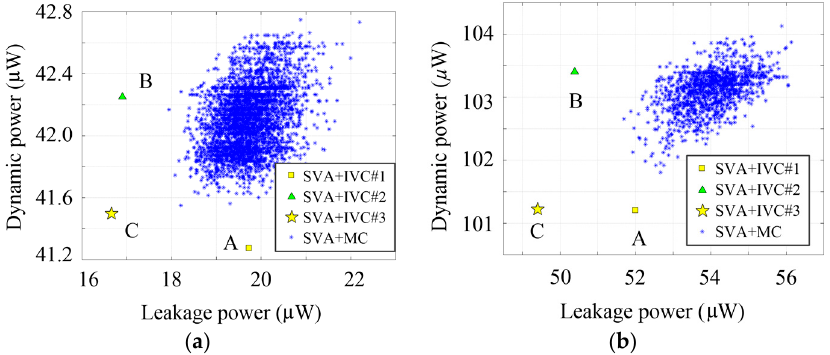
Figure 9. Leakage and dynamic power of SVA for c880 and c3540 circuits when using the input vector obtained by MC simulation and our proposed IVC #3 method. ( a ) c880 circuit; ( b ) c3540 circuit.